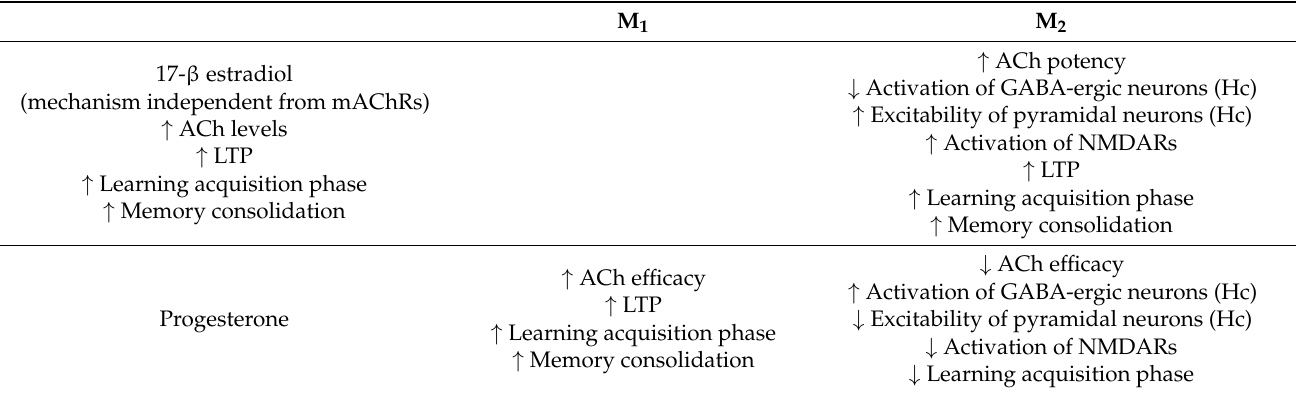
Table 3. Effects of the steroids on the muscarinic signalling in cognitive decline and